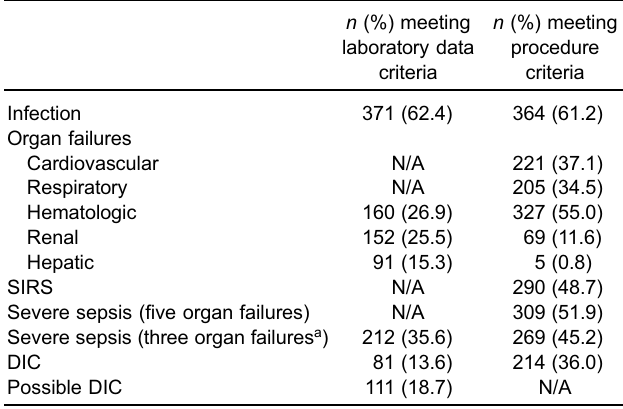
Table 3. Identi fi cation using laboratory data or procedures ( n = 595)